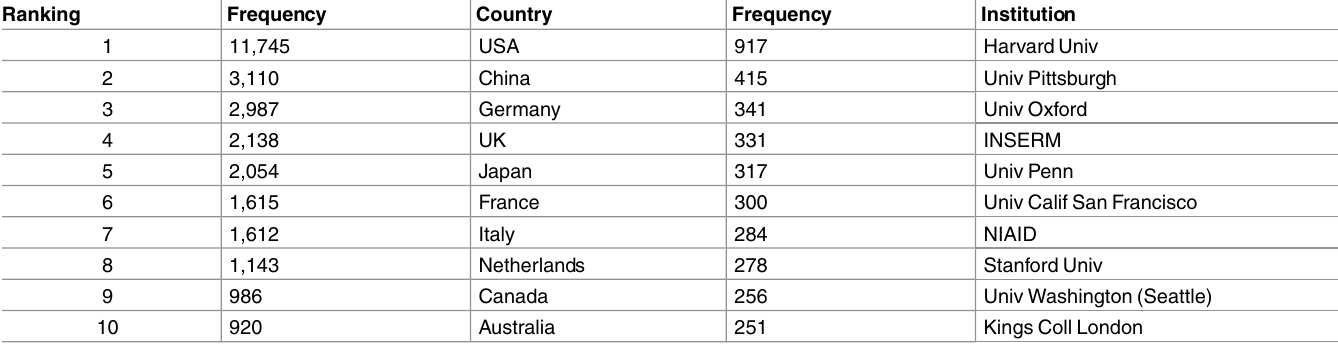
Table 3. Rankingof countriesand institutions thatpublished articlesrelatedto regulatory T cell (Treg) research from 2000 to 2015.